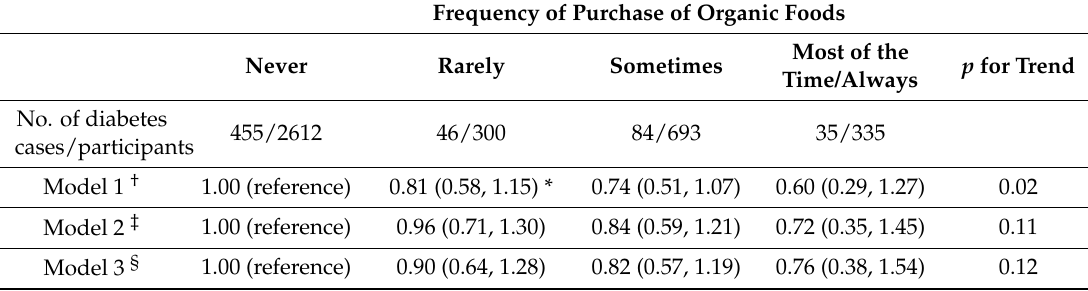
Table 3. Association between the frequency of purchase of organic foods and diabetes among 3940 participants, NHANES